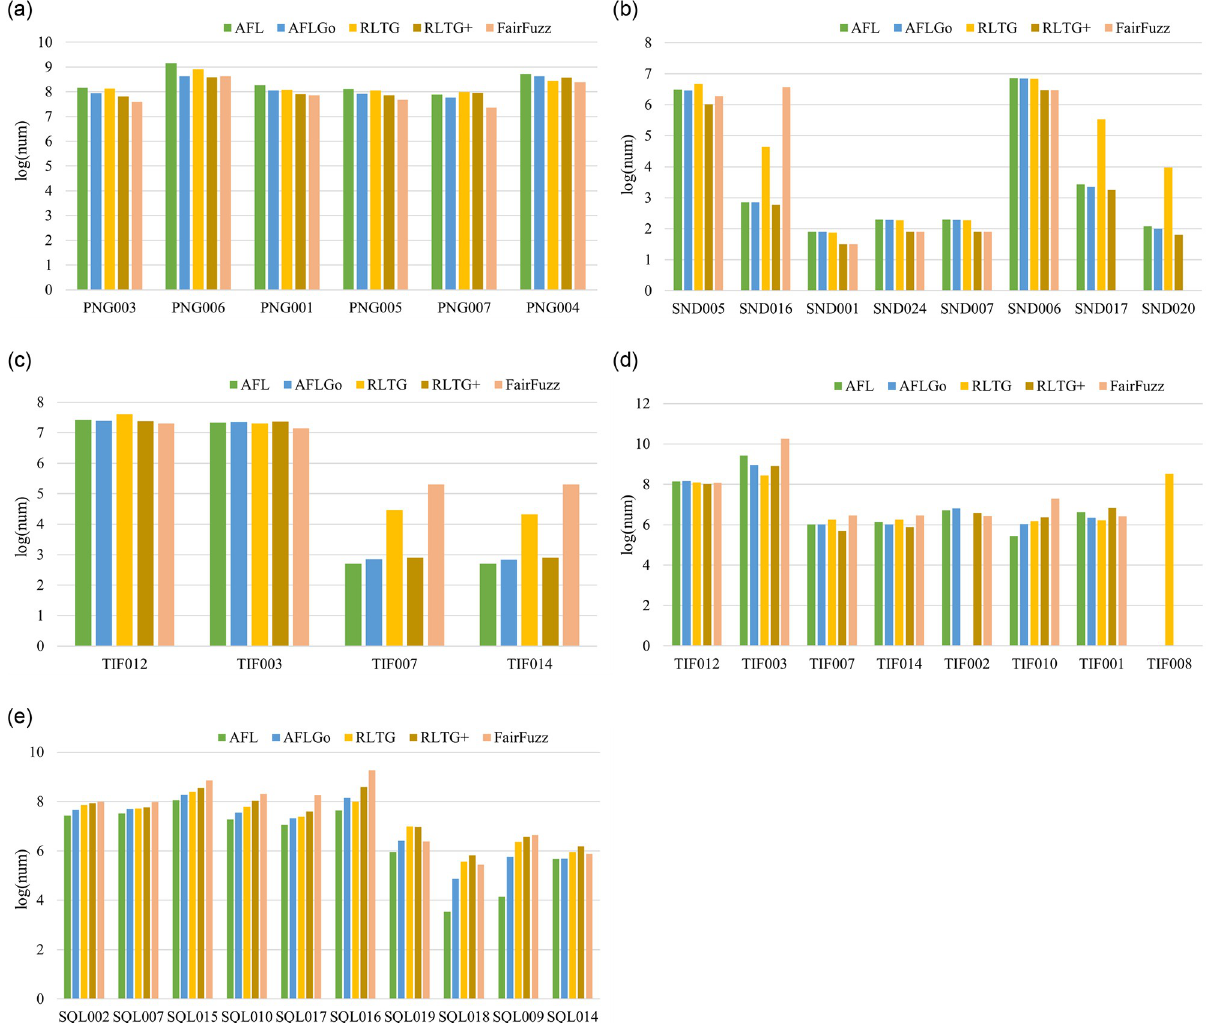
Fig 5. Number of testcases reaching the targets in RLTG, AFLGo, and AFL against magma. All fuzzing times were cut off at 12 hours. The X-axes indicates the vulnerability ID in magma. The Y-axes indicates the hit count in the vulnerability basic block A.libpng B.libsndfile C.tiffcp D. tiff_read_rgba_fuzzer E.sqlite_fuzzer.